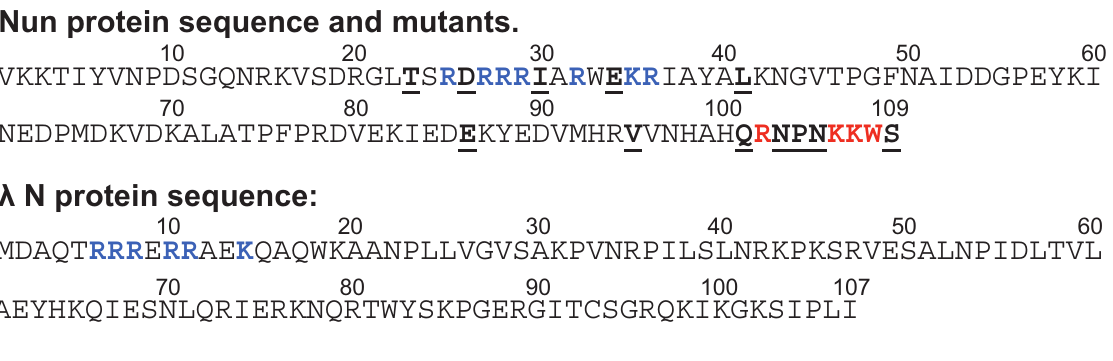
Figure 3. The sequence of Nun and N proteins. Blue—residues of ARM motif. Red—Residues with arrest-deficient phenotype. Underlined—other mutations affecting Nun